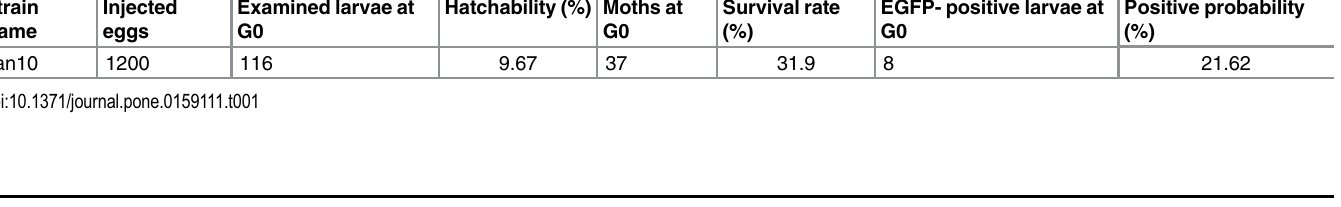
Table 1. The efficiency of the transgenic experiment. Strain Injected Name